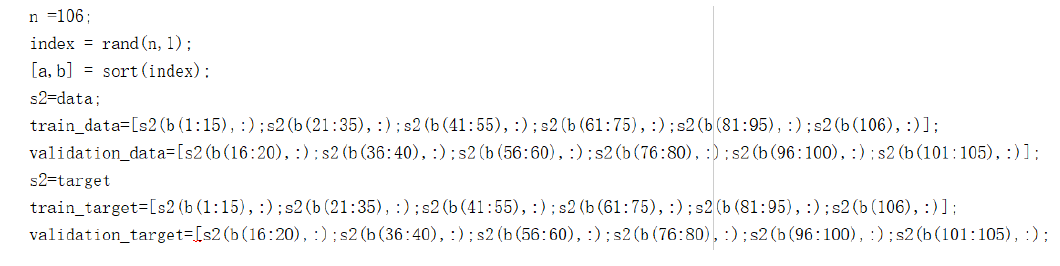
Figure A1. Matlabcode for training set and validation set separation of 106 orange samples.